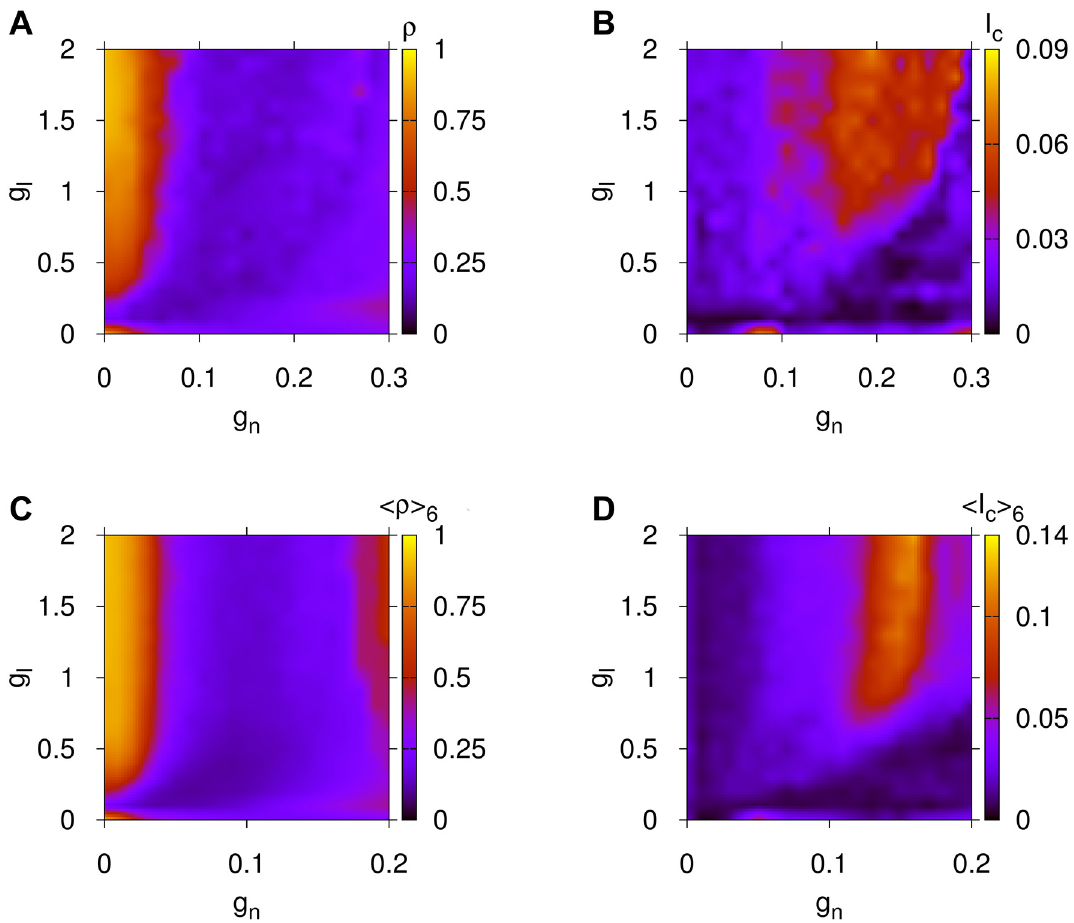
Fig 2. Magnification for the global synchronization and information flow capacity properties of Fig 1. Panel (A): Parameter space for ρ and panel (B) for I c for the C.elegans BDN. Panel (C): Similarly for h ρ i 6 and panel (D) for the averaged upper bound for MIR, h I c i 6 , of the six human BDNs. Here, g n is the chemical and g l the electrical coupling of Eq